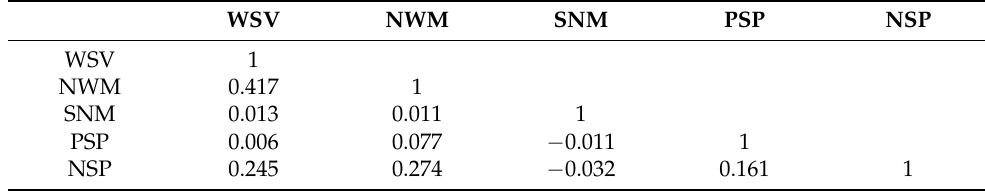
Table 2. Correlation coefficient analysis between key